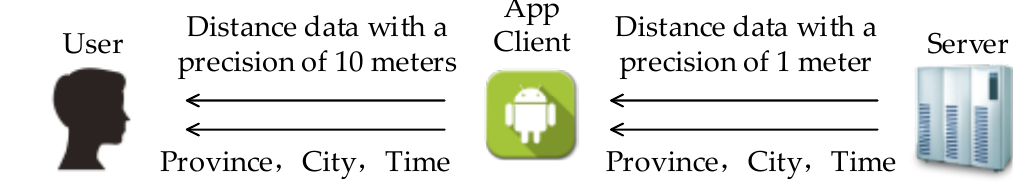
Figure 6. Displayed precision and actual precision of distance data.